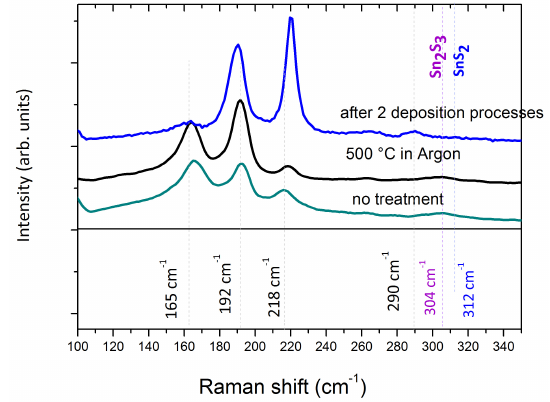
Figure 5. Raman spectra of the SnS raw material, as bought from TRM. The two measurements were carried out on the same sample in different areas.